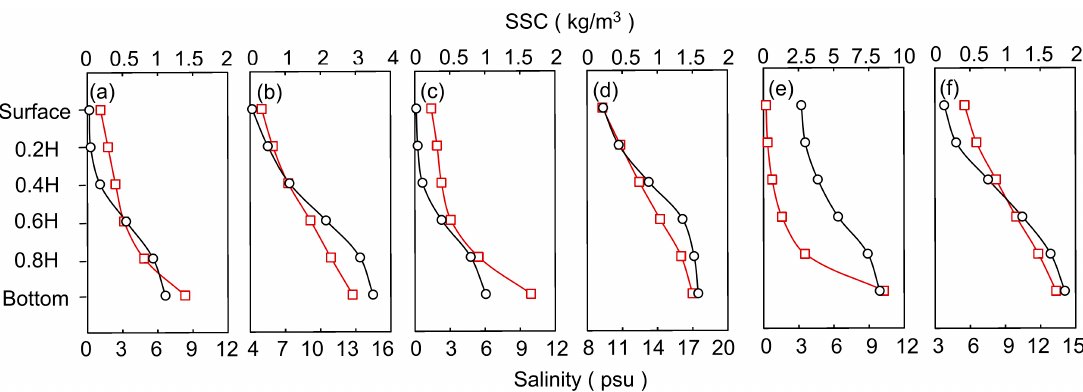
Figure 10. Vertical profiles of tidal-averaged SSC and salinity at CSW: The red line represents SSC, and the black line represents salinity. The ( a – f ) represent six observations respectively (according to Figure